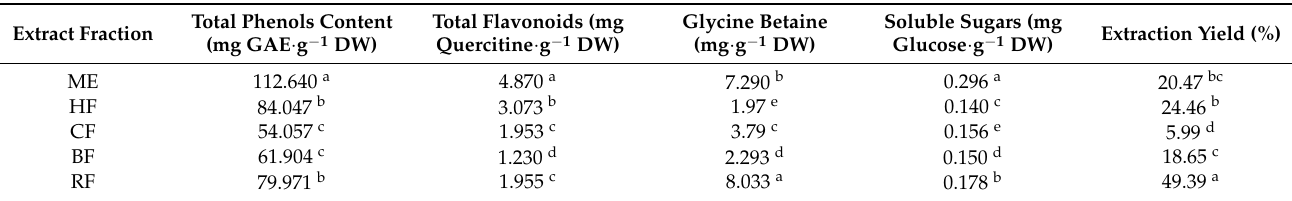
Table 1. Biochemical characterization of Ulva lactuca methanol extract (ME), hexane fraction (HF), chloroform fraction (CF), n-butanol fraction (BF), and residual fraction (RF).